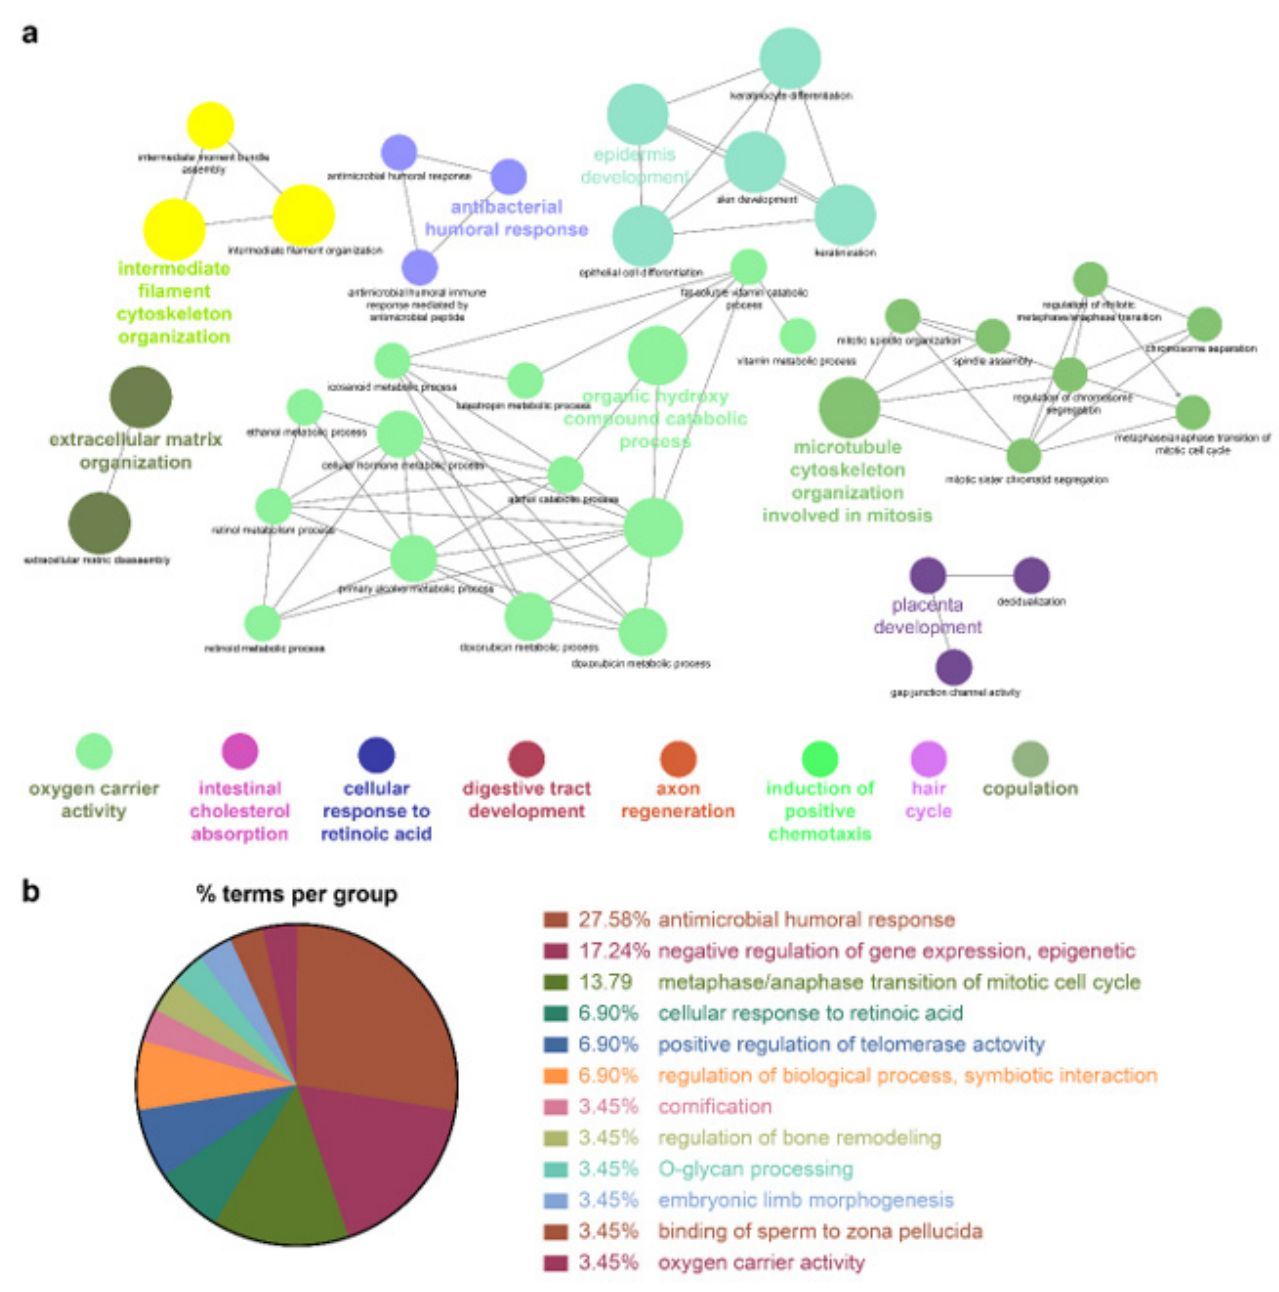
Figure 5. GO enrichment and pathway analysis of LUAD features. ( a ) Enriched GO “Biological Process” terms of LUAD were grouped based on shared genes (Kappa score threshold = 0.4). Enriched terms by p value corrected with Bonferroni were retained as the functional description. The node size is proportional to the degree of significance. ( b ) % terms per group represents the proportion of GO terms in the LUAD